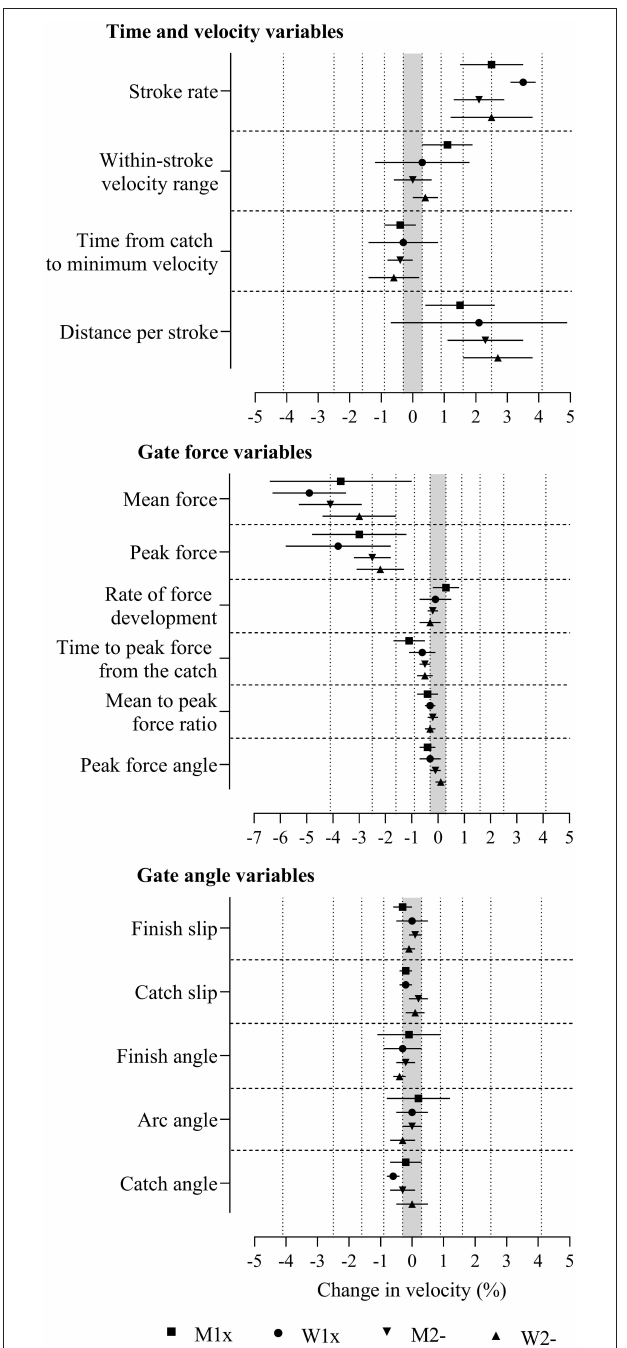
FIGURE 2 | Change in boat velocity for a change in predictor variables of two within-crew standard deviations with adjustment for power output in the four boat classes. Data are mean (%) and 90% compatibility limits. The shaded grey area covers values within the smallest important change thresholds (-0.3% to 0.3%). Vertical dotted lines delineate threshold magnitudes of small ( ± 0.3), moderate ( ± 0.9), large ( ± 1.6), very large ( ± 2.5), and extremely large ( ± 4.1). Rejection of the non-inferiority or non-superiority hypothesis occurs when compatibility limits do not enter the grey area. Effects with compatibility limits that end within the grey area have adequate precision but are only possibly or likely substantial. M1x, men’s single sculls; W1x, women’s singles sculls; M2-, men’s coxless pairs; W2-, women’s coxless pairs.